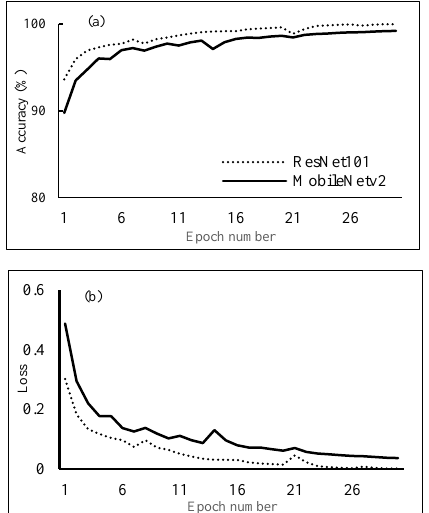
Figure 6. Comparison of training accuracy (6(a)) and loss (6(b)) of models